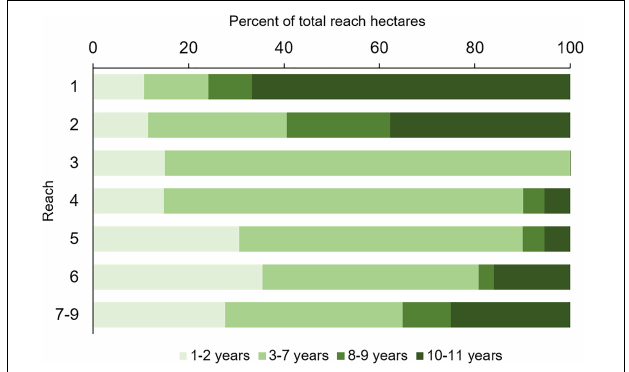
FIGURE 7 | Percent of total hectares of seagrass within each reach that persisted for differing numbers of maps.